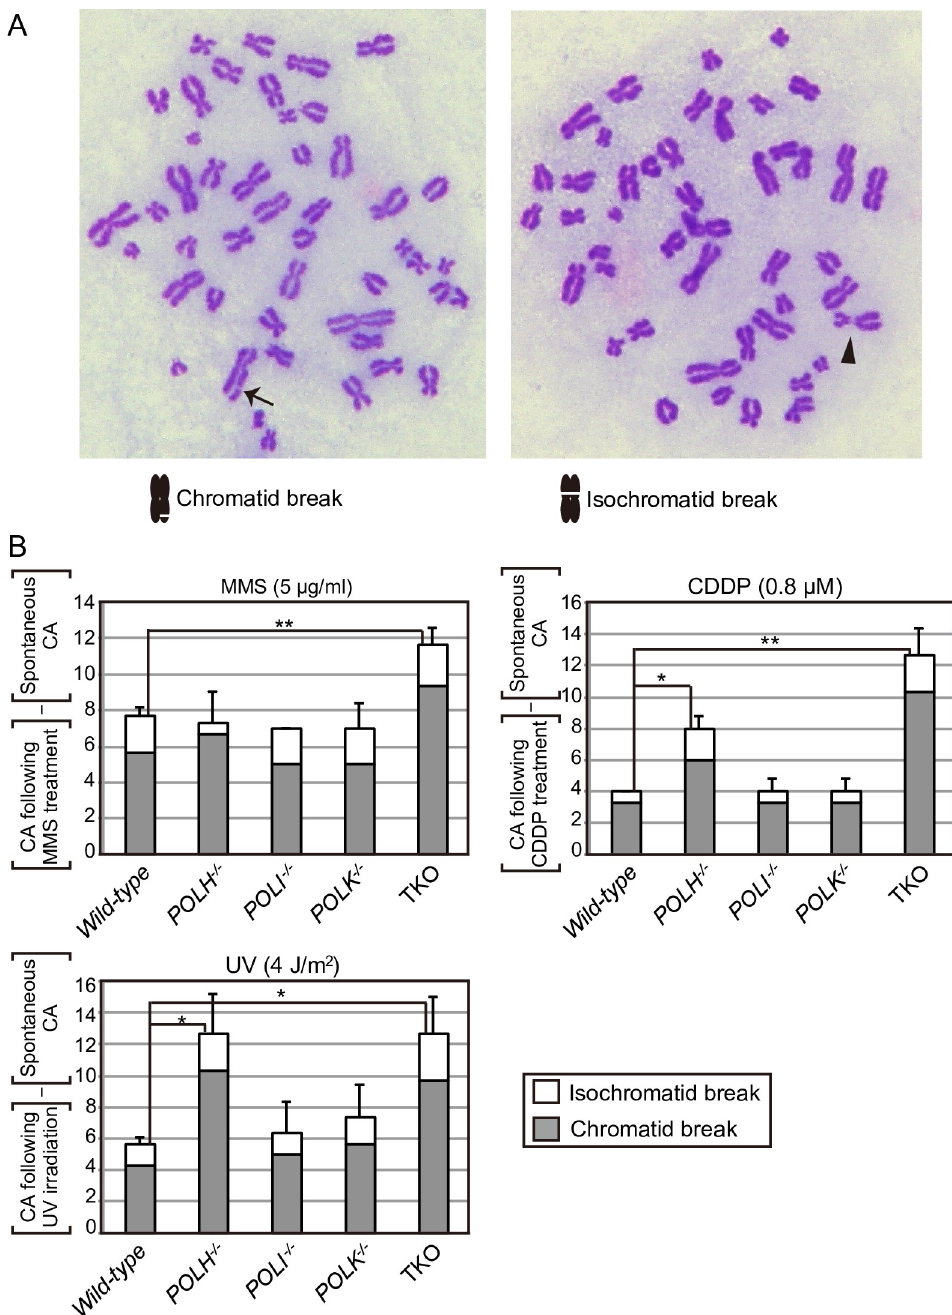
Fig 3. Contribution of Pol η , Pol ι , and Pol κ in preventing chromosomal breakage after exposure to MMS, CDDP, or UV. (A) Representative images showing chromosomal aberrations. The arrow and arrowhead indicate a chromatid break and an isochromatid break, respectively. (B) TK6 cells were cultured in a medium containing CDDP (0.8 μ M) or MMS (5 μ g/mL) for 12 h or exposed to UV (4 J/m 2 ) and cultured for 12 h. Cells were treated with colcemid for the last 3 h. The number of chromosomal aberrations (CAs) per 100 mitotic cells before and after the 12-h treatment was scored three times; the average and standard deviation from three experiments are presented in S6 Fig. The number of spontaneous CAs was subtracted from the number of DNA-damaging agent-induced CAs and is shown in the histogram. Error bars represent the standard deviation from three independent measurements. The p -value was calculated by Student’s t -test ( � p < 0.05, �� p <